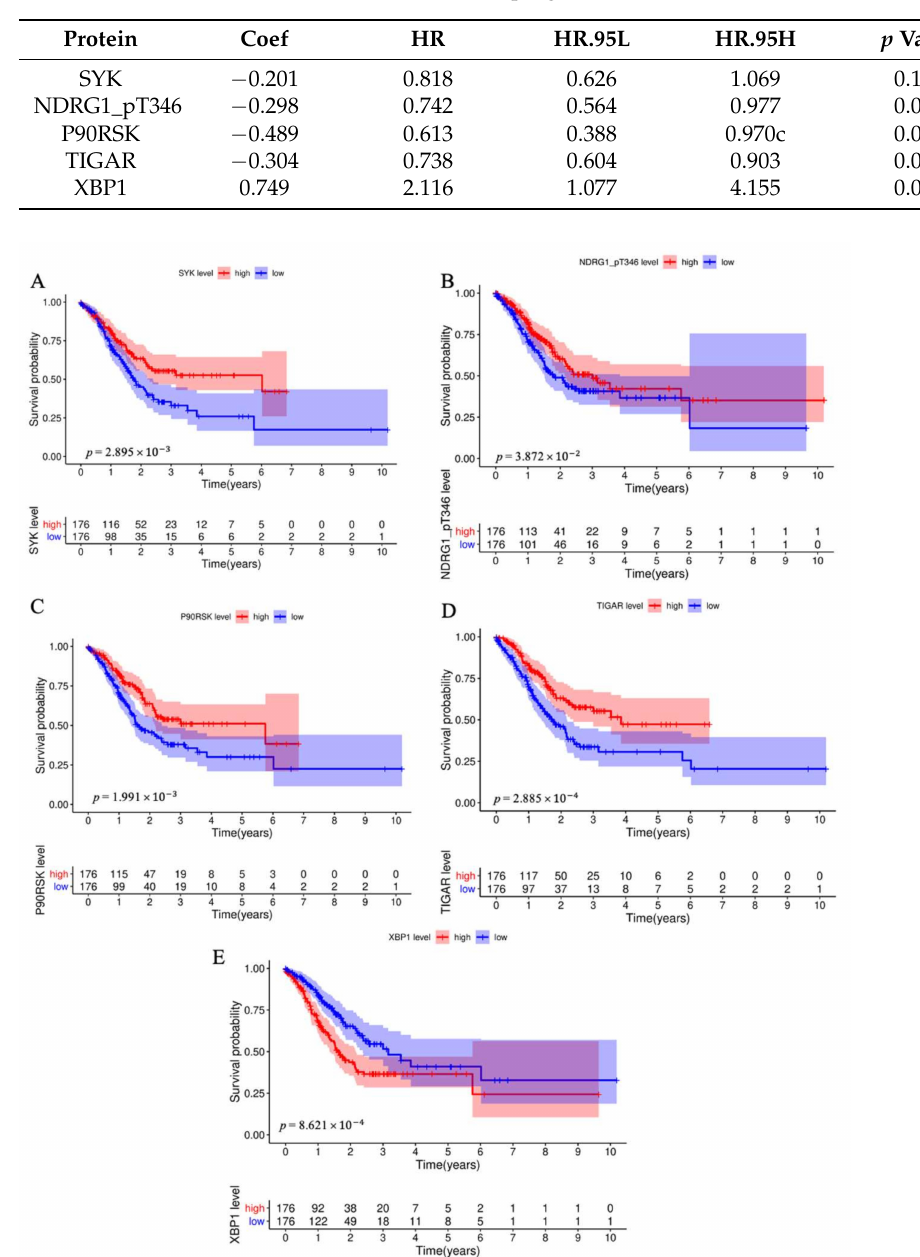
Table 2. Proteins used for the construction of risk prognostic model.